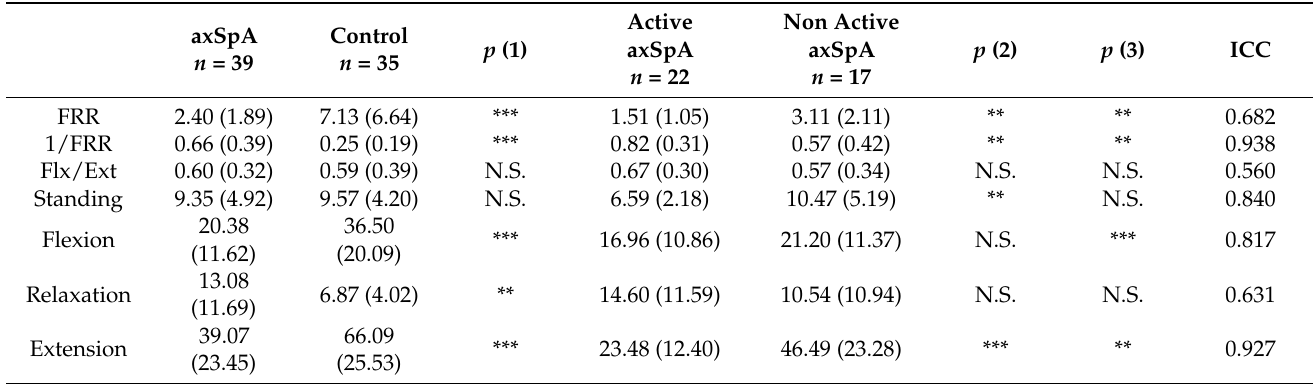
Table 2. Average values in each phase by group, significant differences, and reliability results.